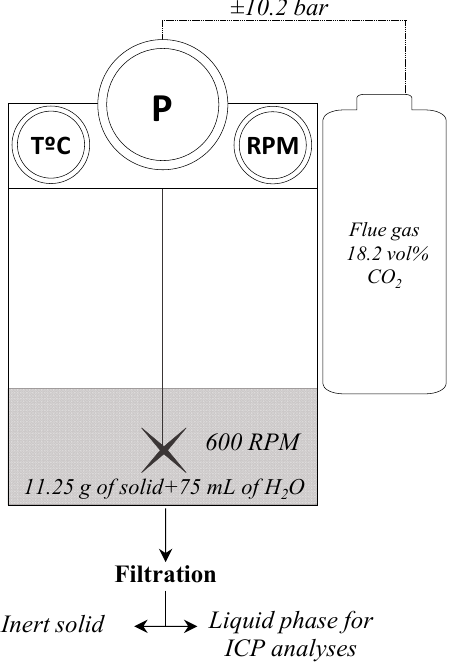
Figure 1. Parr reactor experimental set up.